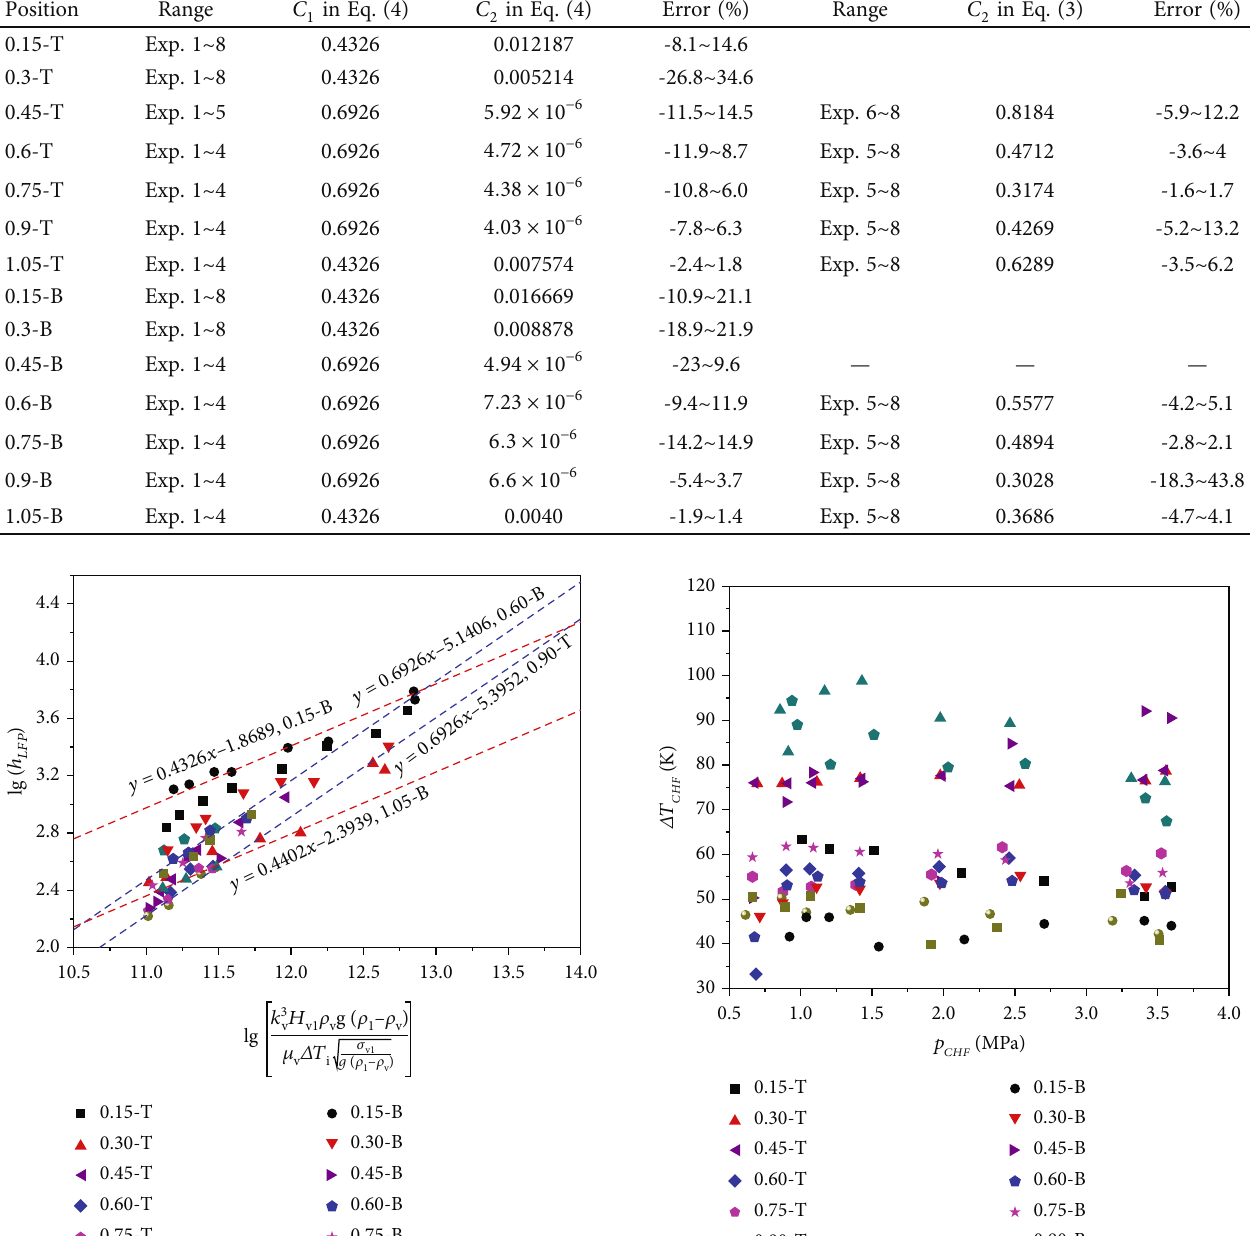
and C values and 1 2